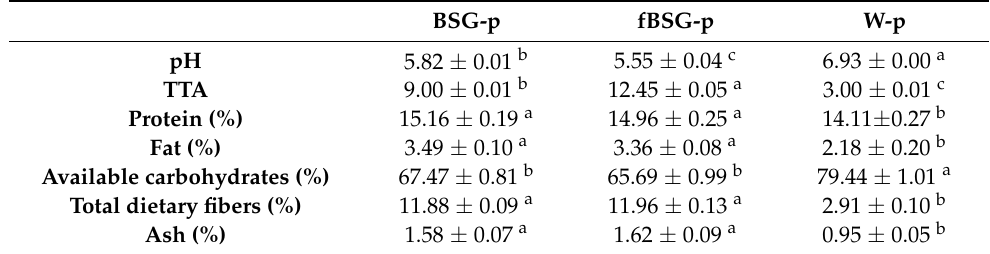
Table 2. Biochemical properties of pasta containing fermented and native brewers’ spent grain: BSG-p, pasta containing native brewers’ spent grain (15% wt/wt in replacement of semolina); fBSG-p, pasta containing fermented brewers’ spent grain (15% wt/wt in replacement of semolina); W-p, pasta made with durum wheat semolina.